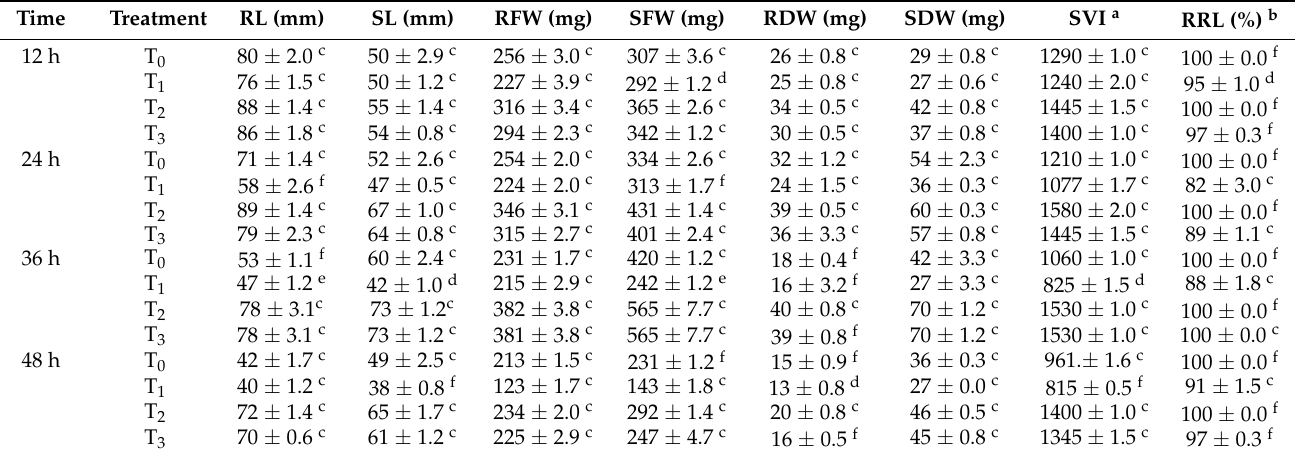
Table 6. Influence of strain A7 on the growth of chickpea in a stressed